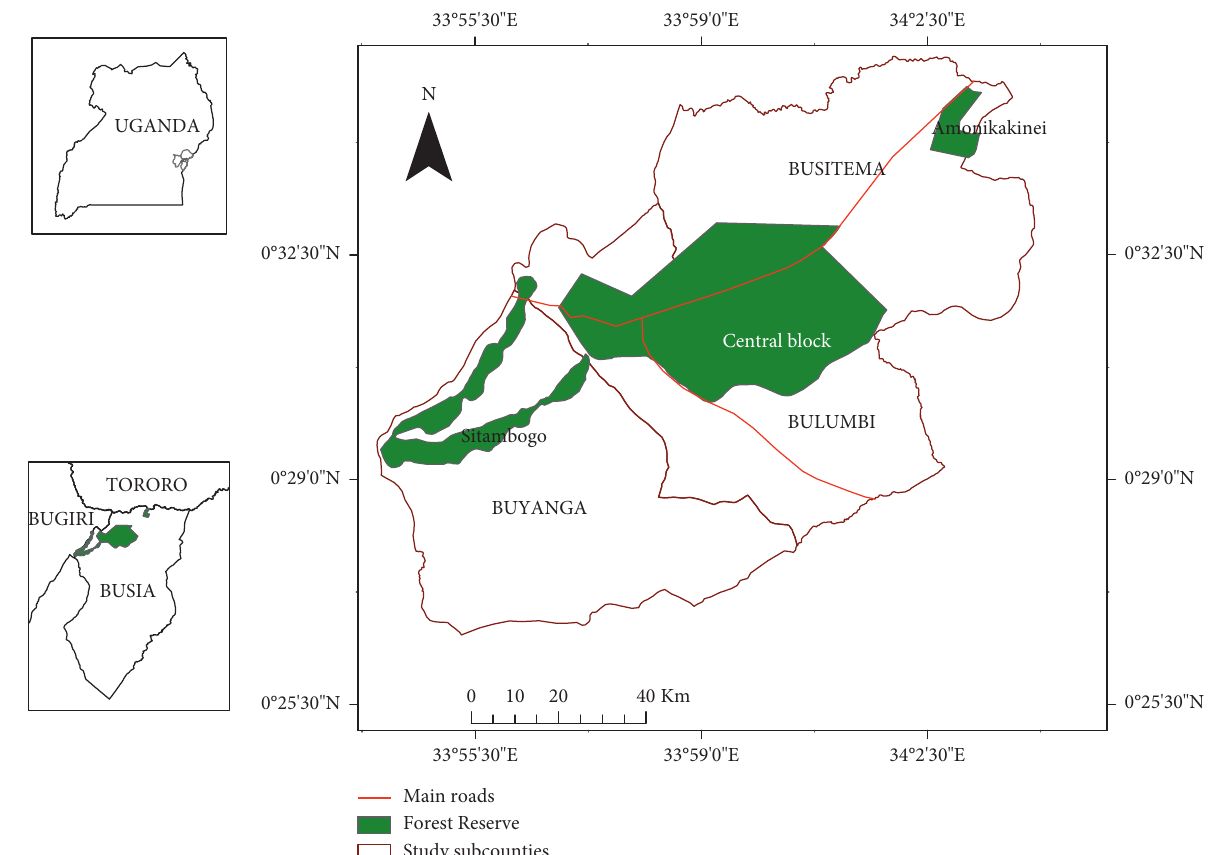
Figure 1: West Bugwe Central Forest Reserve. Inset is location of WBCFR within Busia district (lower panel on the left) and in Uganda (top panel on the